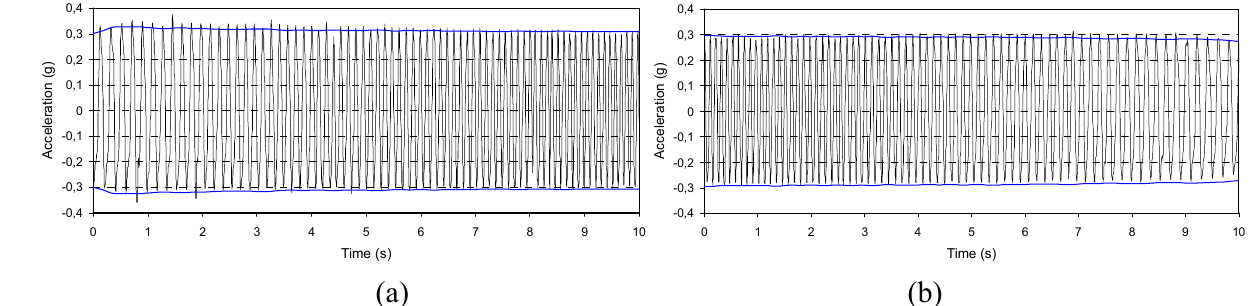
Figure 9. Sine sweep before dynamic excitation: 0.3 g amplitude, 0.5 Hz/s sweep ratio, y-axis. The horizontal lines correspond to the vibration level measured by the piezoelectric accelerometer used as feedback signal; increasing frequency 5–10 Hz (a) and decreasing frequency 10–5 Hz (b).